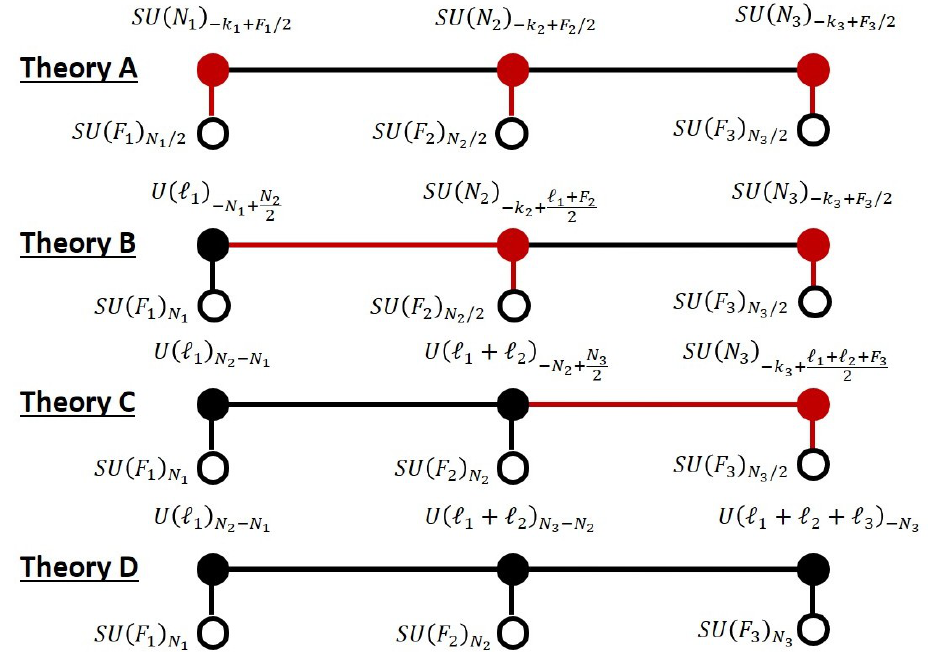
Figure 8. Flavored quiver with fermions on the SU side and scalars on the U side. This is an alternate theory in the (cid:13)avor extended case. Here we have introduced the notation ‘ i (cid:17) F i (cid:0) k i